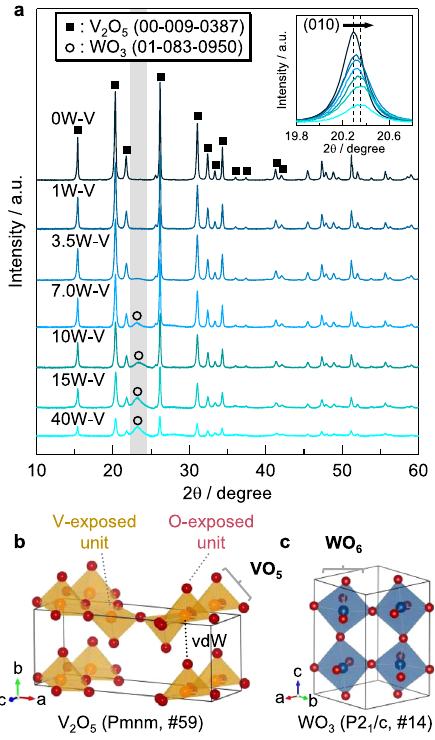
Fig. 2 Crystal structures of W-substituted vanadium oxide catalysts. a XRD patterns of W-substituted vanadium oxide catalysts. Inset: enlarged view of peaks corresponding to (010) re fl ection. (All of the peaks 2 θ > 40° were also assigned to V 2 O 5 .) Crystal structures of b V 2 O 5 and c WO 3 . Orange polyhedra: VO 5 units; blue polyhedra: WO 6 units. VdW van der Waals